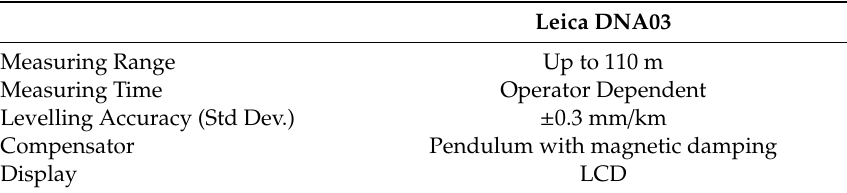
Table 1. Main features of the employed levelling equipment.